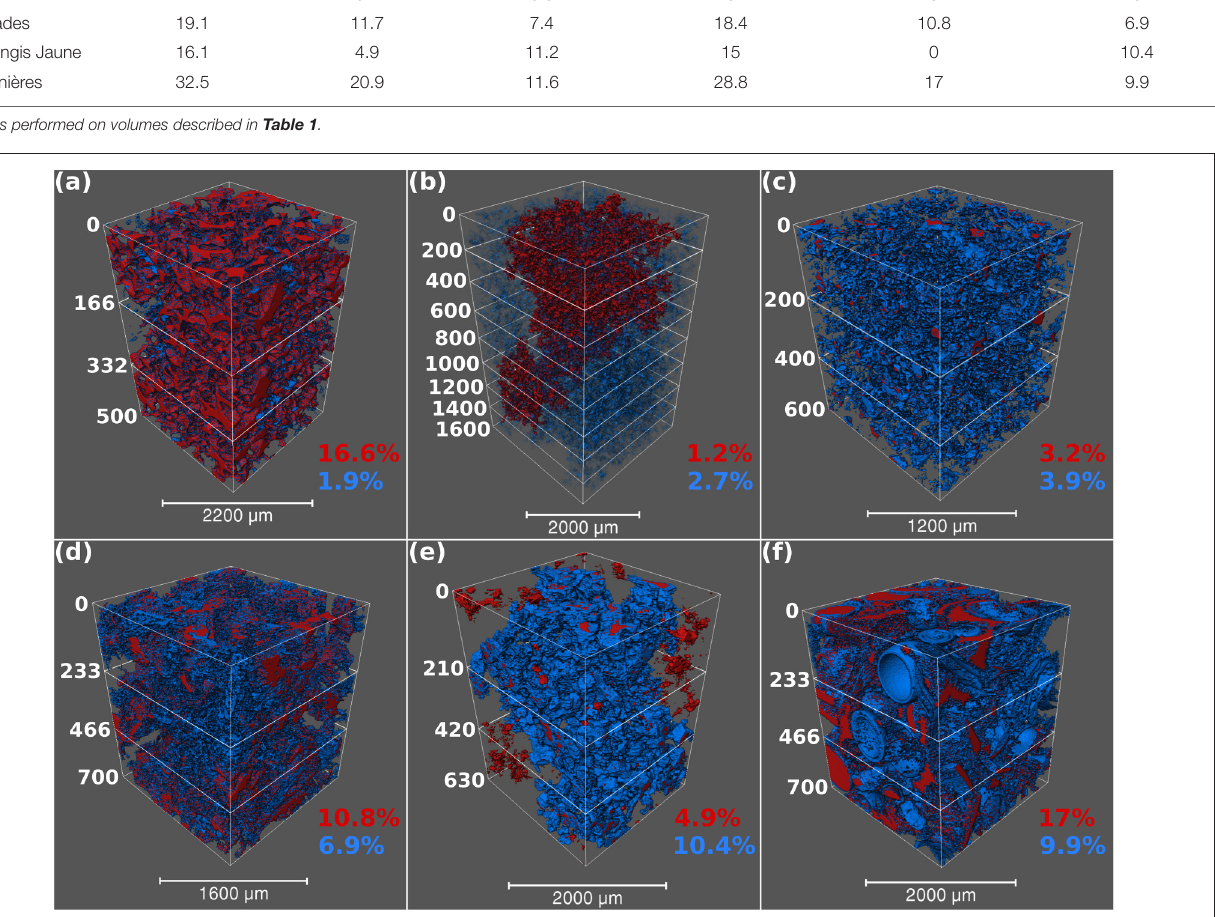
), and connected C